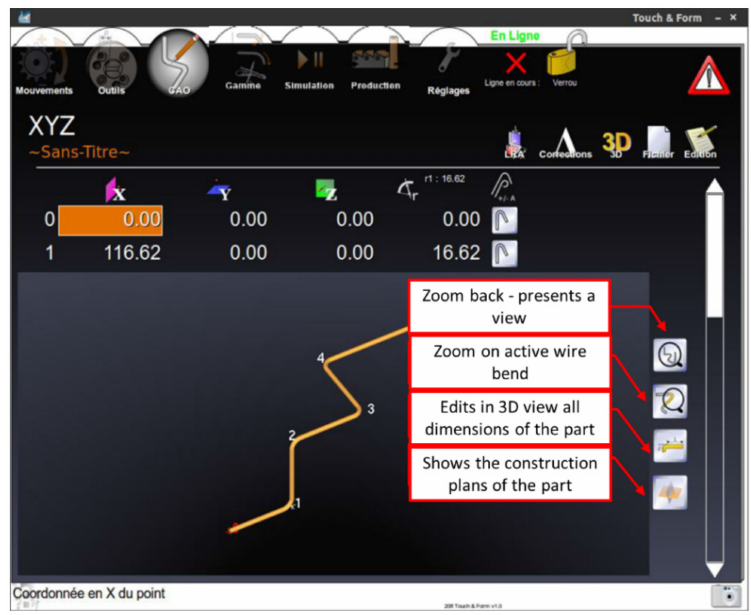
Figure 3. 3D view of the wire in the equipment